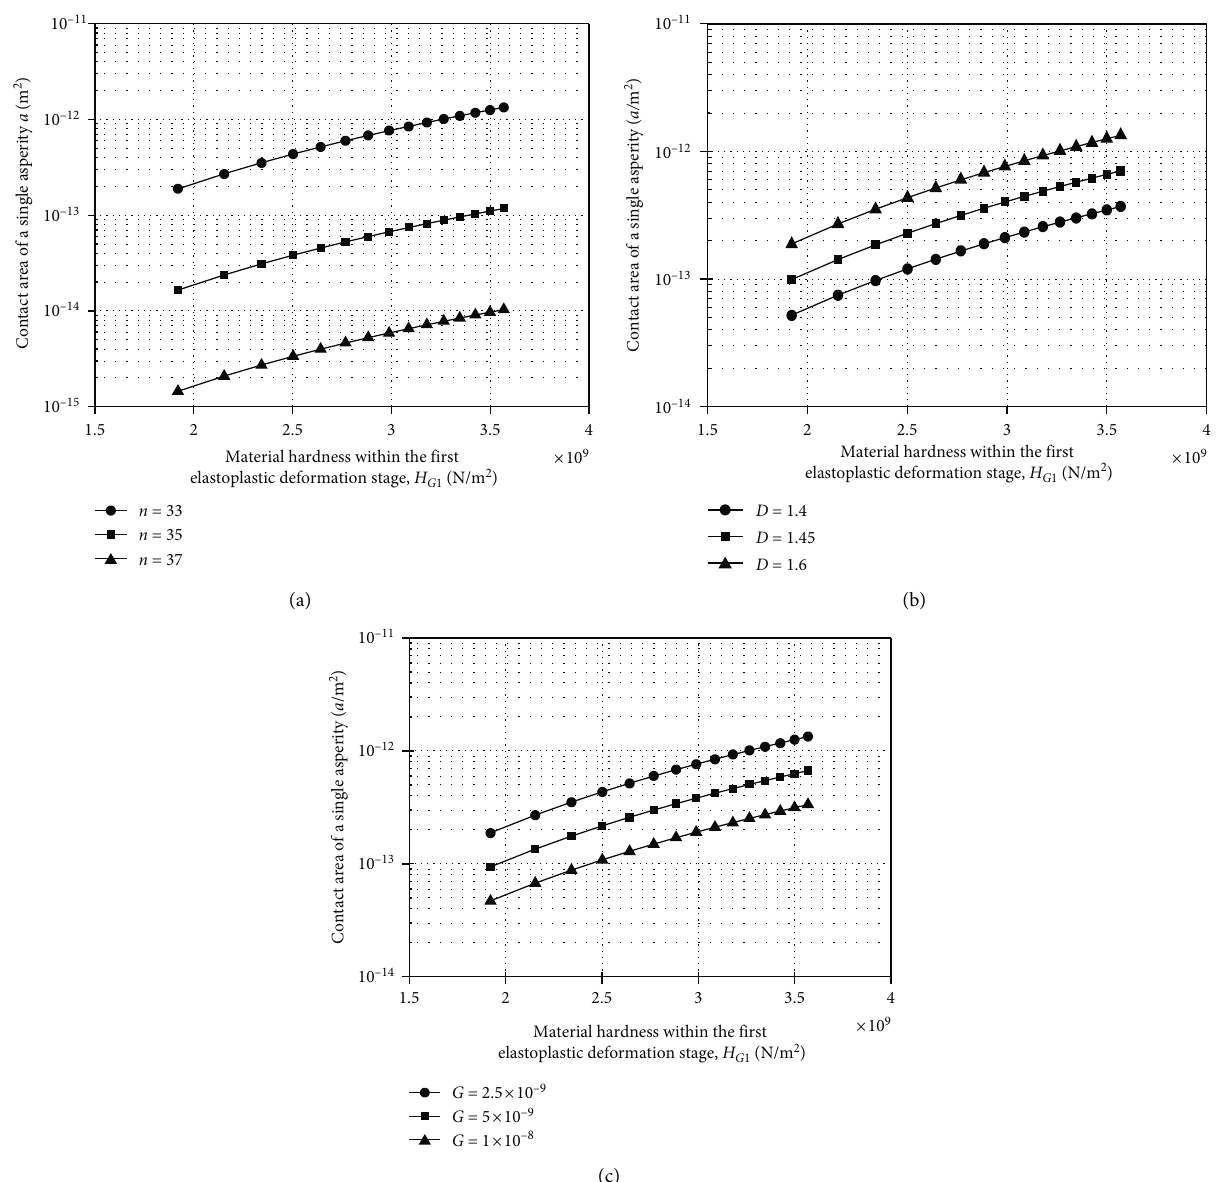
Figure 9: Relationships between the material hardness and the contact area of a single asperity within the first elastoplastic deformation stage. .td.jin Bool Technology Co. (a) D � 1 . 5 ,A r / A a � 0 . 4. (b) n � 33 ,G � 2 . 5 × 10 − 9 , A r / A a � 0 . 4. (c) n � 33 , D � 1 . 5 ,A r / A a � 0 .